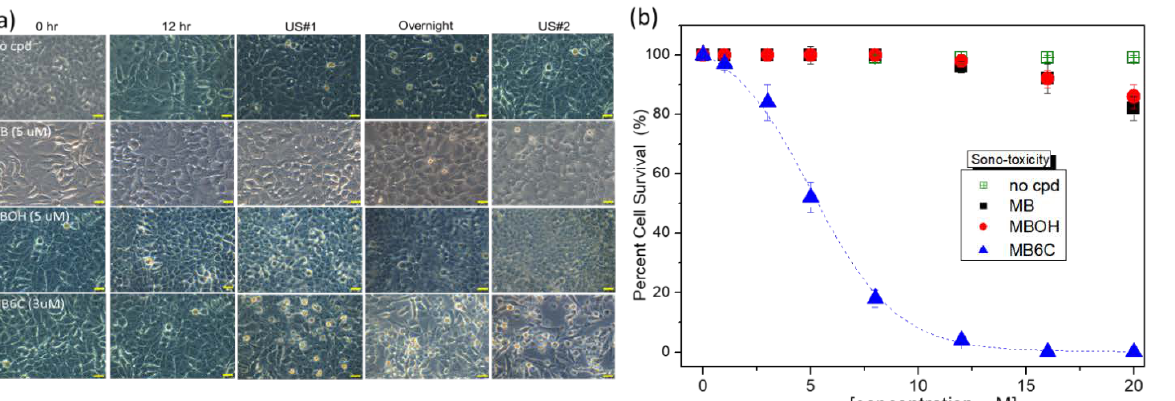
Figure 6. ( a ) Several extracted bright-field photodamage photographs from A549 lung cancer cells incubated with or without phenothiazine derivatives, 5 µM MB, MBOH, and MB6C and 3 µM of MB6C, for 12 h in order to check the dark toxicity. Then cells were irradiated with an average 18 J·cm − 2 of light source (510 nm lp) for 20 min and cell deaths were estimated after a further 12 h. ( b ) Dark toxicity and phototoxicity cell viability plots of A549 cells treated with variable concentrations of phenothiazine derivatives, as in the experiment in ( a ). Each datapoint is the average from three separate experiments. ( c ) Fluorescent photodamage images extracted from experiment ( a ) to check the cellular uptake for every compound in ( a ).